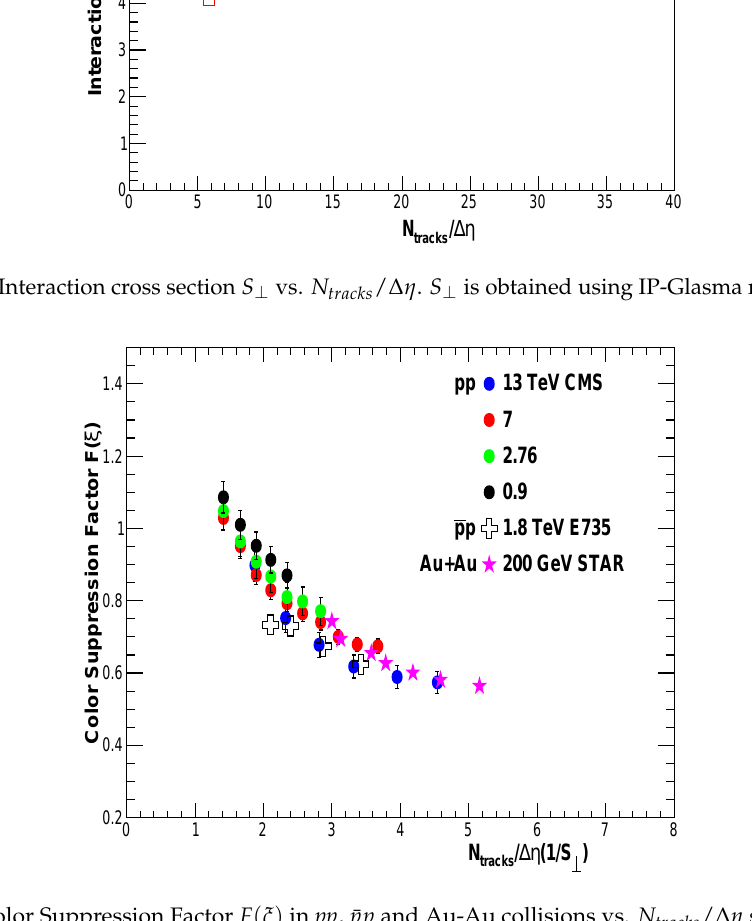
Figure 7. Color Suppression Factor F ( ξ ) in pp , ¯ pp and Au-Au collisions vs. N tracks / ∆ η scaled by the transverse area S ⊥ . For pp and ¯ pp collisions S ⊥ is multiplicity dependent as obtained from IP-Glasma model [22]. In case of Au-Au collisions the nuclear overlap area was obtained using the Glauber model